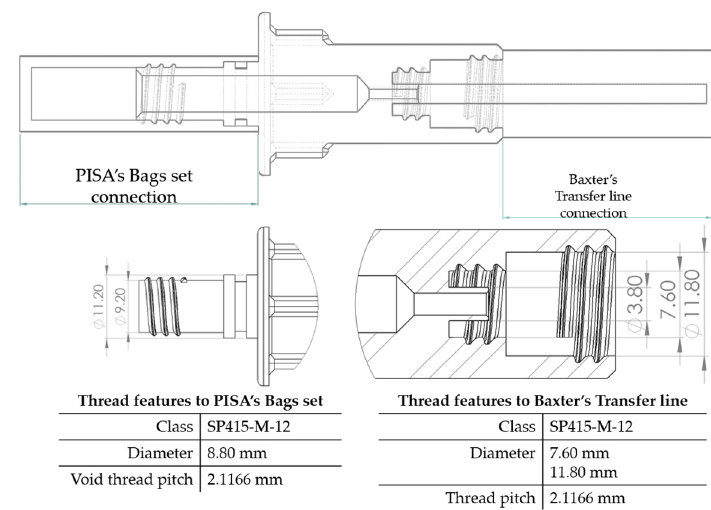
Figure 7. PB connector, join points, and thread features.